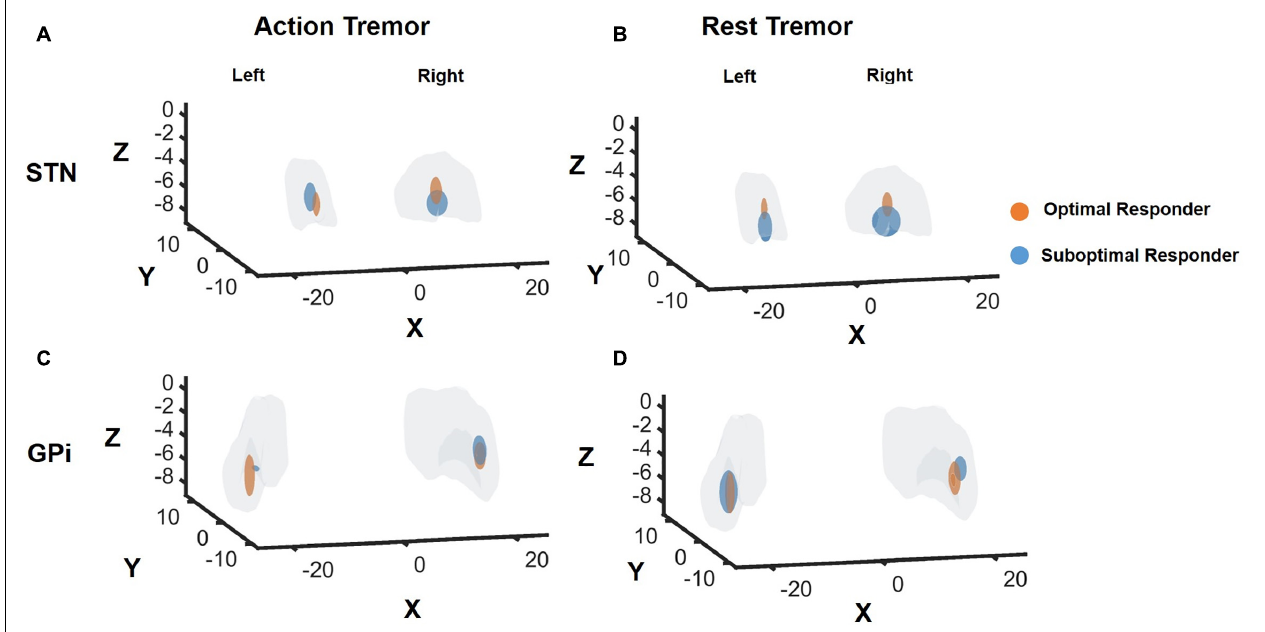
FIGURE 4 | DBS contact locations in Optimal Responders versus Suboptimal Responders for STN and GPi DBS groups. Response for rest tremor and action tremor was individually analyzed. OR, responder, SR, suboptimal responder. “Optimal responders” were defined as patients experiencing > 2 point decrease in the UDPRS Part III item 20 and 21 for rest and action tremor, respectively. “Suboptimal responders” were defined as < 2 point decrease in the UDPRS Part III item 20 and 21 for rest and action tremor, respectively. The gray region in panels (A,B) represents the STN while the gray region in panels (C,D) represent the GPi. The orange bubble represents the “optimal responders,” and the blue bubble represents “suboptimal responders.” The size of the bubble is not electric field or volume of tissue activated. The size of the bubble represents the variance within each subgroup. While there were no significant differences between the two subgroups for action tremor control regardless of the target and rest tremor control with GPi DBS; however, rest tremor control with STN DBS suggested the optimal contact was slightly dorsal in location as seen along the z